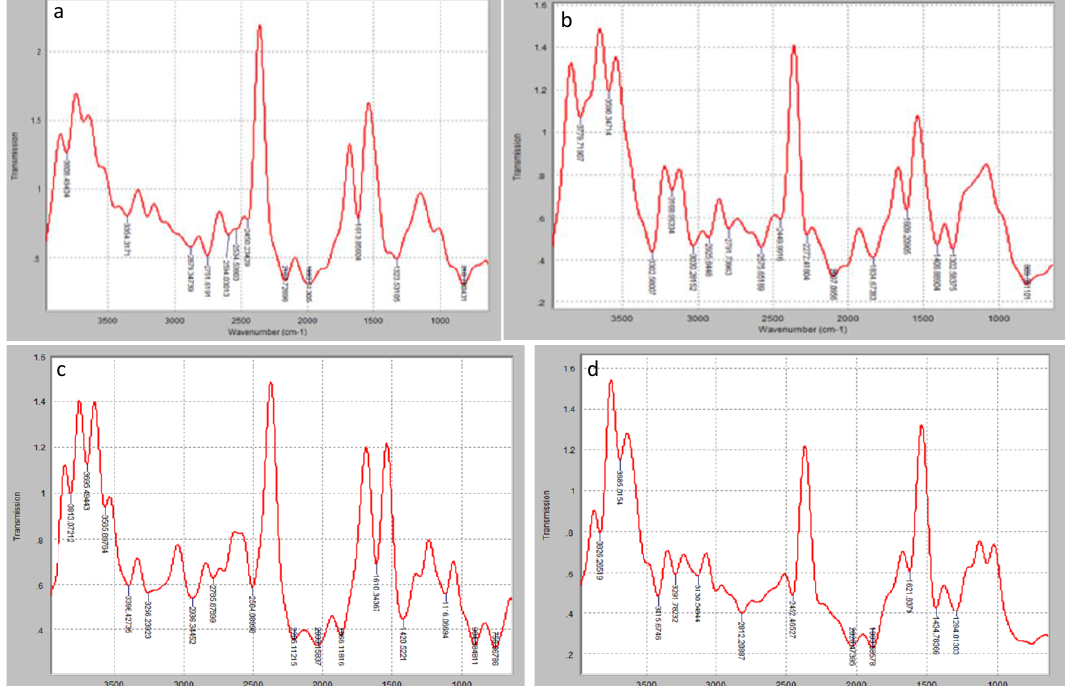
Figure 2: FTIR spectrum of (a) ScCSNPs (b) ScCSNPs.AgNPs (c) ArCSNPs (d) ArCSNPs-AgNPs